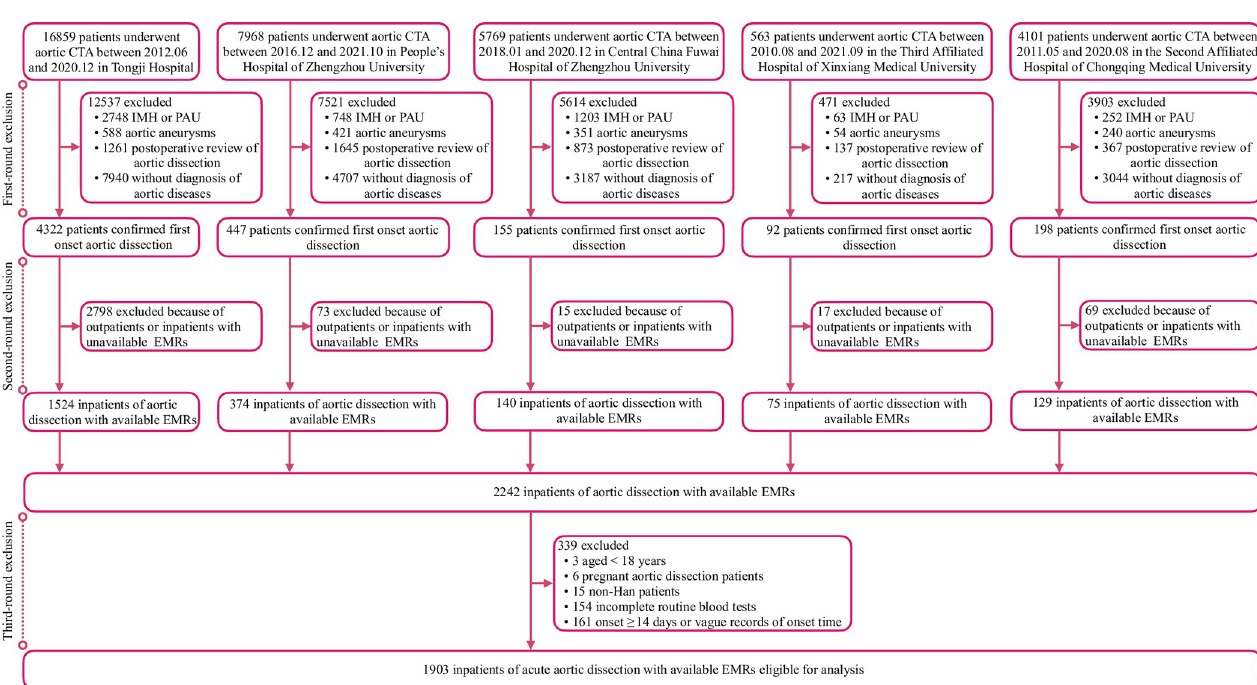
Fig 1. Flowchart of the study. CTA, computed tomographic angiography; IMH, intramural hematoma; PAU, aortic pseudoaneurysm; EMRs, electronic medical records.